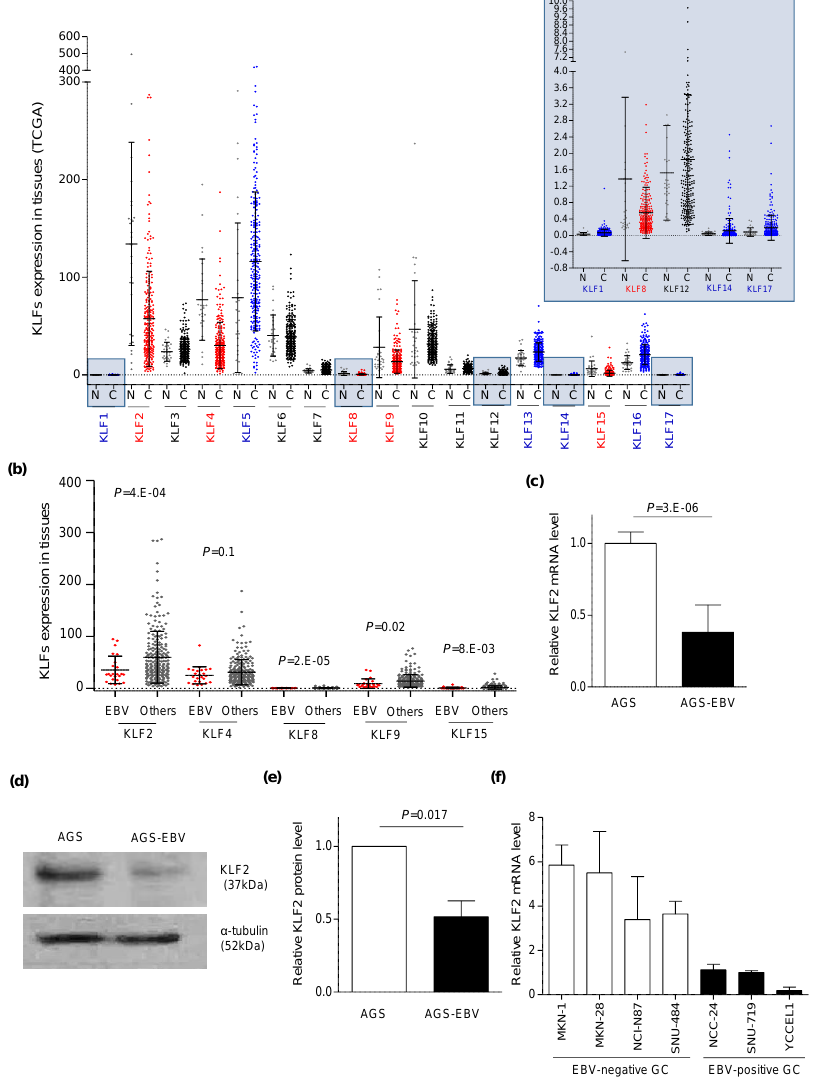
Figure 1. Suppressed Kruppel-like factor 2 ( KLF2 ) expression by Epstein-Barr Virus (EBV) infection in gastric carcinoma. ( a ) RNA sequencing data from The Cancer Genome Atlas (TCGA) were used to analyze the expression of each KLF in normal tissues (N) and four subtypes of gastric cancer tissues